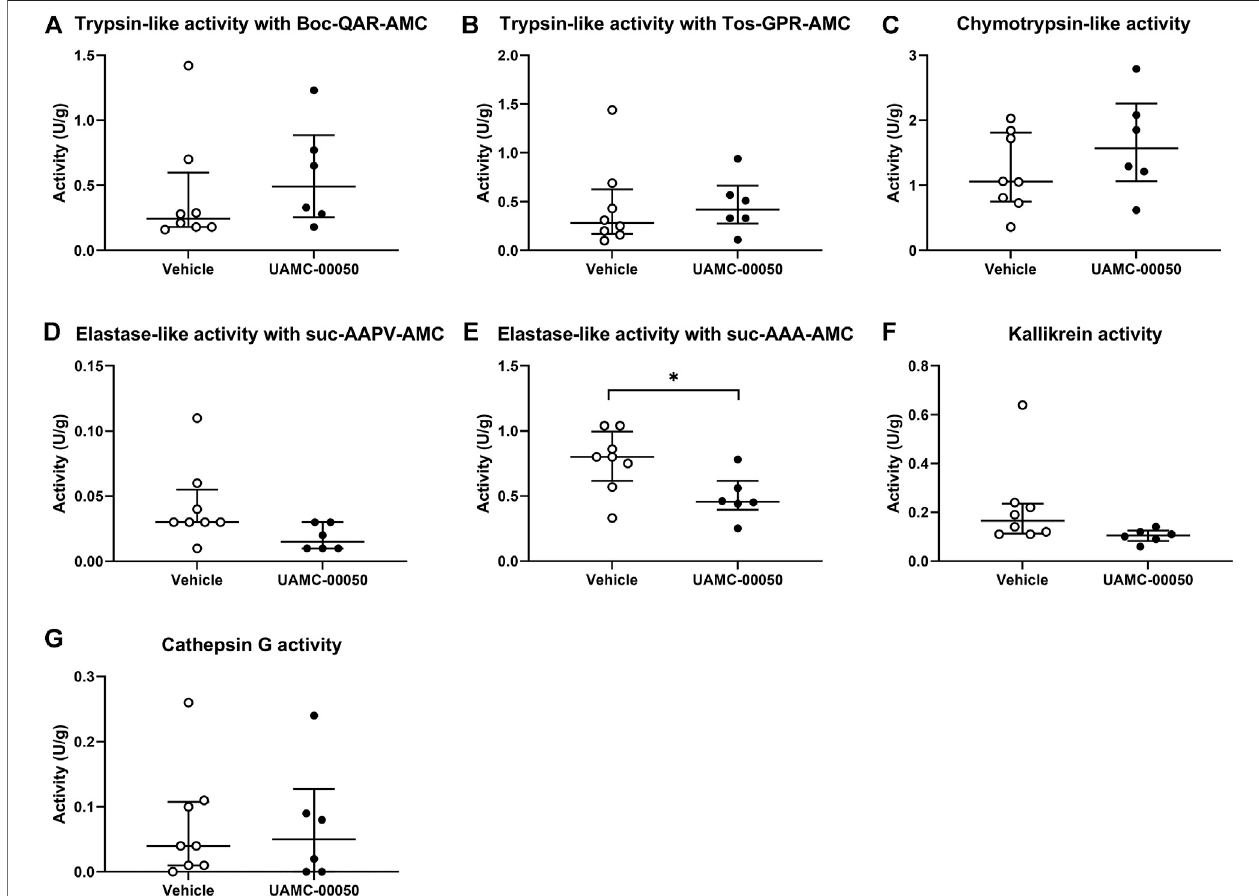
FIGURE5 | Proteolytic activities measured with fl uorogenic substrates in colon samples from acute colitisrats treated with UAMC-00050(1 mg/kg) or vehicle (5% DMSO). (A) Trypsin-likeactivitymeasuredwithBoc-QAR-AMC (B) Trypsin-likeactivitymeasuredwithTos-GPR-AMC (C) Chymotrypsin-likeactivitymeasuredwithsuc- AAPF-AMC (D) Elastase-likeactivitymeasuredwithSuc-AAPV-AMC (E) Elastase-likeactivitymeasuredwithSuc-AAA-AMC (F) KallikreinactivitymeasuredwithH-PFR- AMC (G) Cathepsin-G activity measured with suc-AAPF-AMC and the cathepsin G inhibitor I. Data are presented as median with interquartile range (IQR). Data were analyzed by Mann – Whitney U tests with Bonferroni correction for multiplicity; n = 6 – 8 per group. Analysis was performed on the full dataset (involving the four combinationsofcontrol/post-colitisandvehicle/UAMC-00050),howeveronlydatafromtheacutecolitisgroupwereshowninthis fi guresincedatafromtheothergroups were previously published. * p < 0.05; signi fi cantly different from colitis + vehicle.